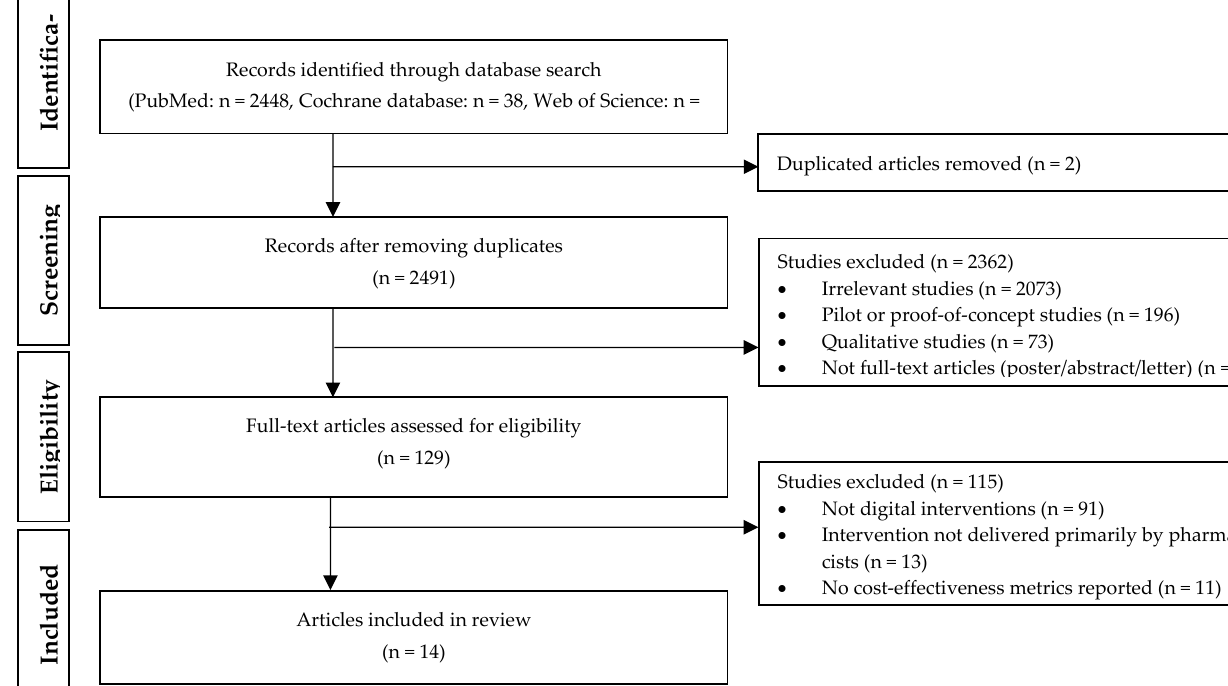
Figure 1. Flow diagram of the search strategy and selection of articles.